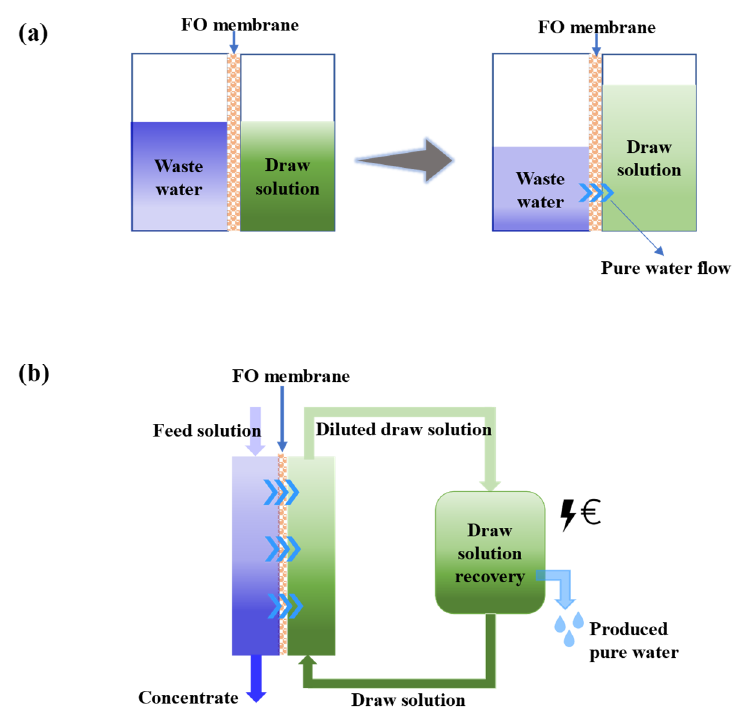
Figure 2. ( a ) Concept of FO and ( b ) a practical FO system coupled with a draw solutes regeneration unit (adapted from [44] ).